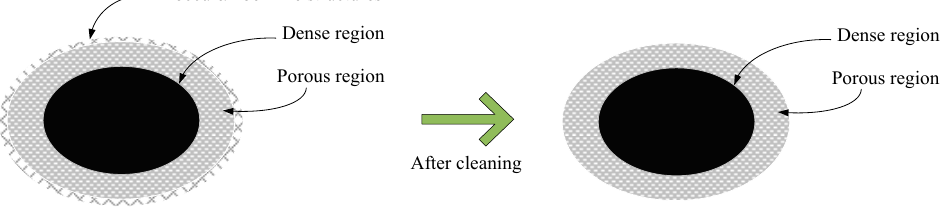
Figure 4. The effect mechanism of ultrasonic cleaning on surface morphology change.